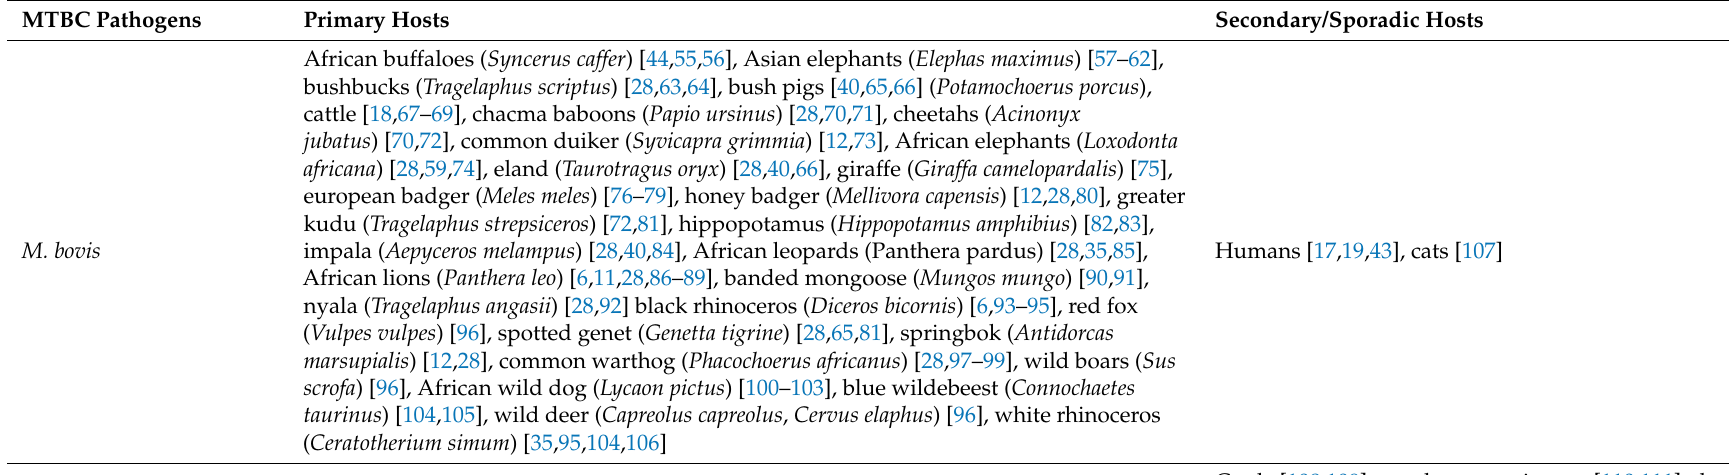
Table 1. Mycobacterium tuberculosis complex pathogens and their